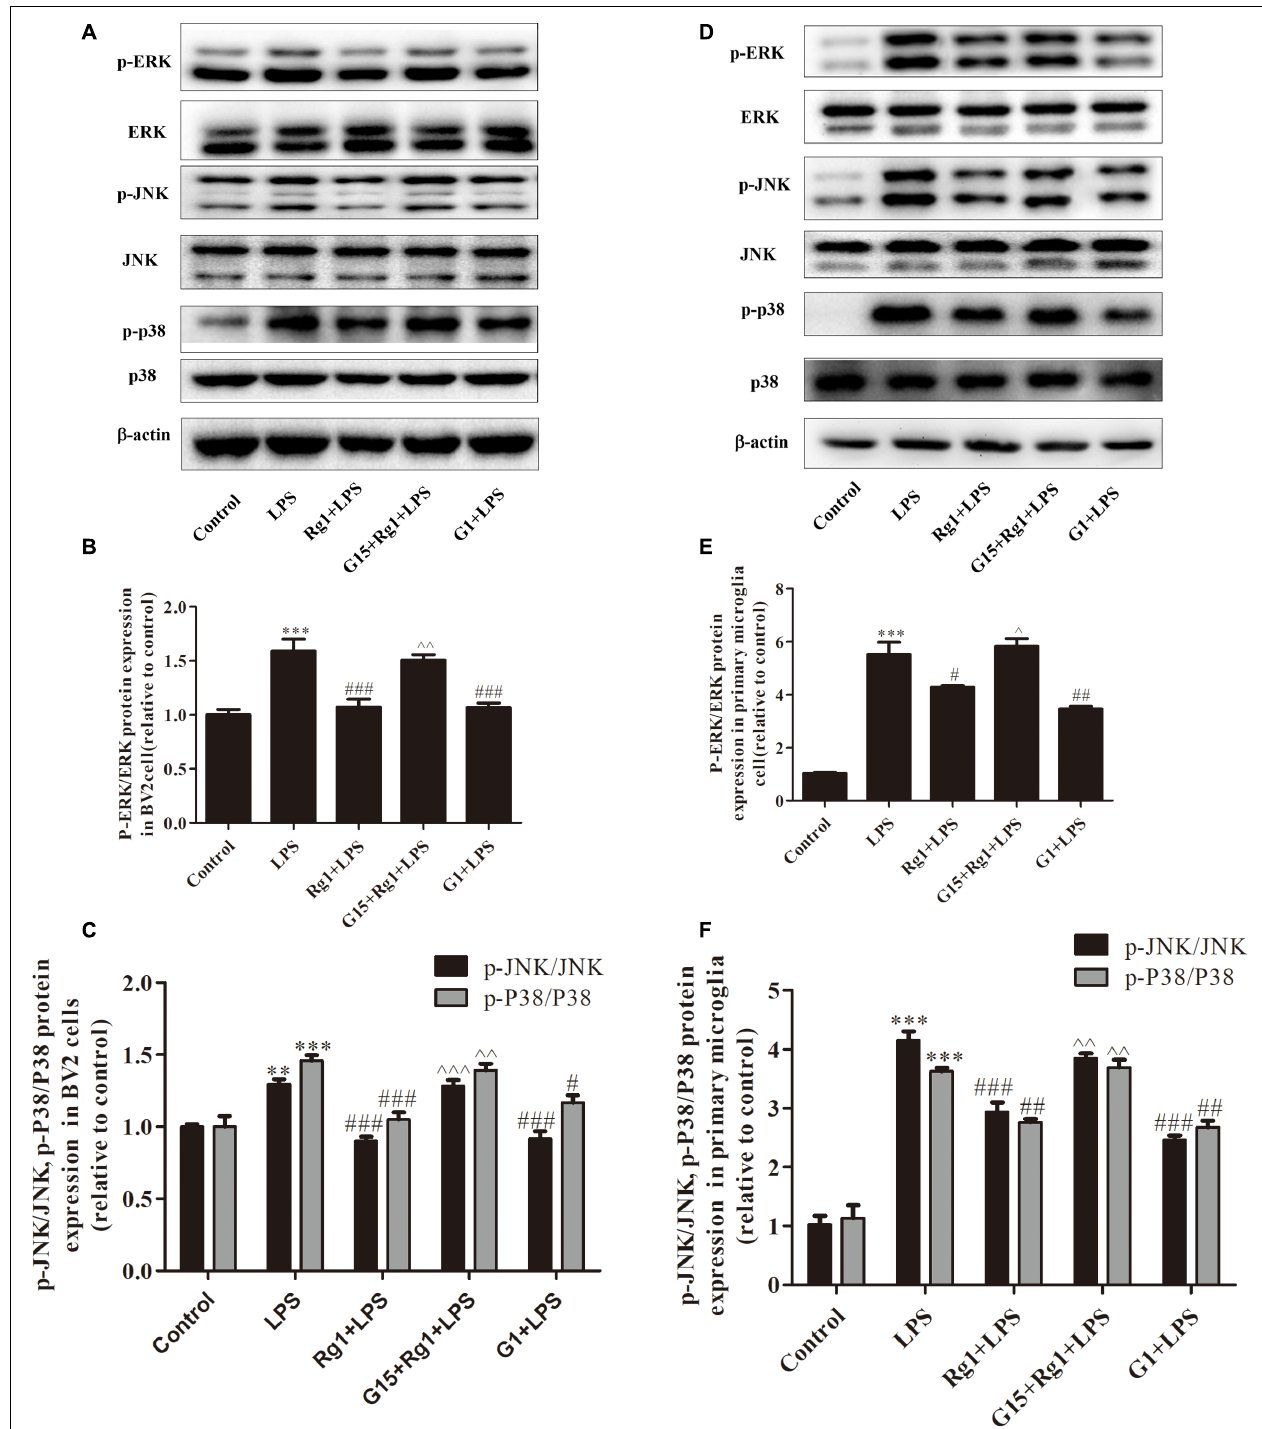
FIGURE 4 | The GPER was involved in the anti-inflammatory effects of Rg1 on the activation of MAPK signaling pathway in BV2 cells and primary microglia. BV2 cells and primary microglia were incubated in DMEM-H without FBS for 4 h, pretreated with 1 µ M G15 for 1 h, followed by 10 µ M Rg1 or 1 µ M G1 for 1 h, and stimulated with LPS (BV2 cells: 1 µ g ml − 1 ; primary microglia: 0.5 µ g m − 1 ) for 0.5 h. Cell lysates were prepared and subjected to western blot. The phosphorylation level of ERK, c-Jun-N-terminal kinase (JNK), and p38 were detected by western blot in BV2 cells (A–C) and primary microglia (D–F) . Equivalent loading of cell lysates was determined by the total ERK, JNK, and P38. Results are expressed as the mean ± SEM, n = 3–4. ∗∗ P < 0.01 and ∗∗∗ P < 0.001 versus control; # P < 0.05, ## P < 0.01, and ### P < 0.001 versus the LPS group; ∧ P < 0.05, ∧∧ P < 0.01, and ∧∧∧ P < 0.001 versus the Rg1 + LPS group.